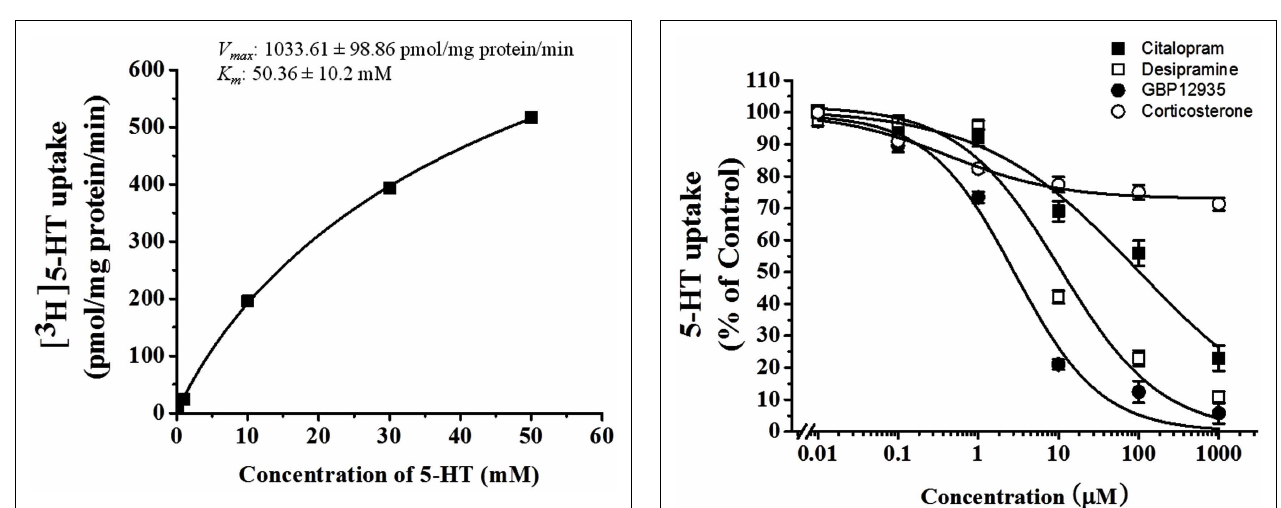
FIGURE 3 | Effects of various transporter inhibitors on 5-HT uptake in HBVSMCs. [ 3 H]5-HT uptake (1 µ M, 2 µ Ci/mL) was measured at room temperature for 30min in the presence of various concentrations of • citalopram ( (cid:4) ), desipramine ( (cid:3) ), GBR12935 ( ), and corticosterone ( (cid:13) ). Values are means ± SEM of three experiments carried out in